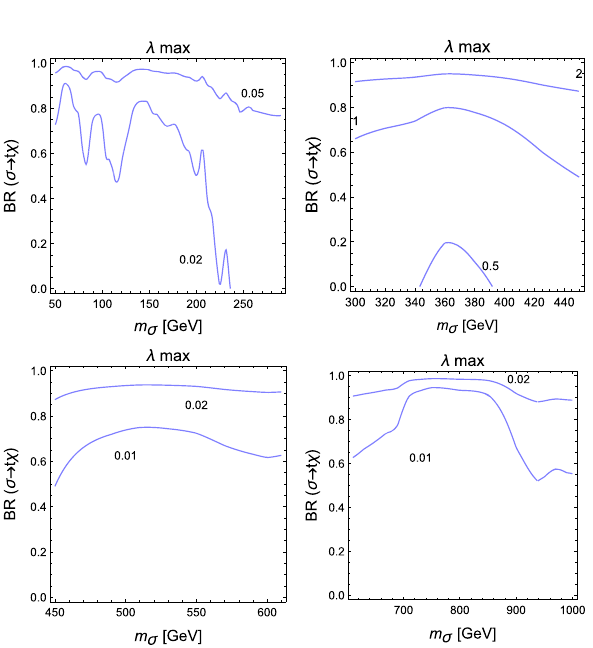
Fig. 3 Upper bound on the λ parameter denoting the coupling strength of the σ resonance to down-type quarks as derived from a variety of dijetsearchesatcolliders.Theresultsarerepresentedinthe ( m σ , BR t χ ) plane, and the regions under the curves are excluded for λ equal to at least the indicated value. In the upper left panel, we reinterpreted the low mass CMS search in the boosted regime [57], whilst on the upper rightpanel,weconsideredtheCDFanalysis[59].Inthelowerleftpanel, we focused on the trigger-based ATLAS analysis [55], and combined it with the similar CMS search [56] in the lower right panel, recalling that the CMS analysis is insensitive to any m σ value smaller than 600